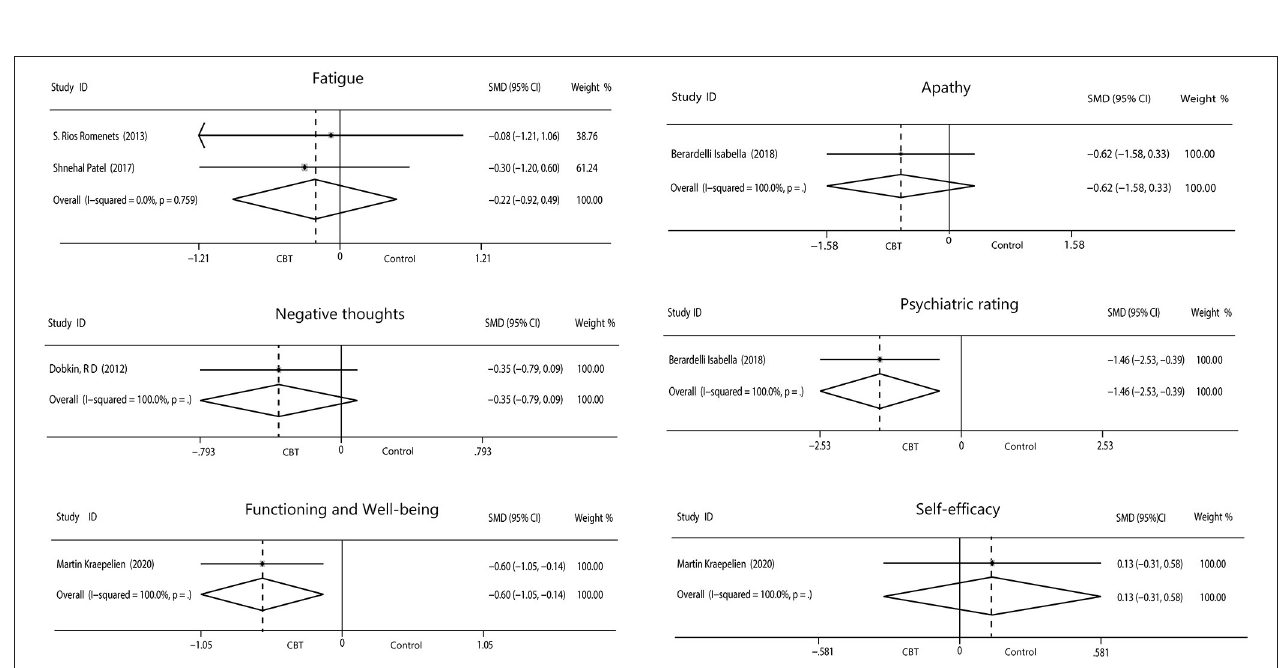
FIGURE 4 | Forest plot of random effects model meta-analysis of the effect of CBT on fatigue, apathy, negative thoughts, psychiatry rating, functioning, and well-being and self-efficacy. CBT, cognitive behavioral therapy.